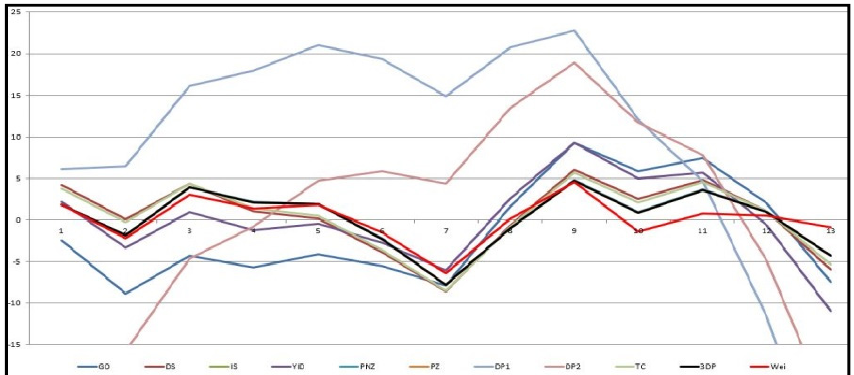
Figure 2. Relative error value of 11 models in Table 1 for Dataset #1.